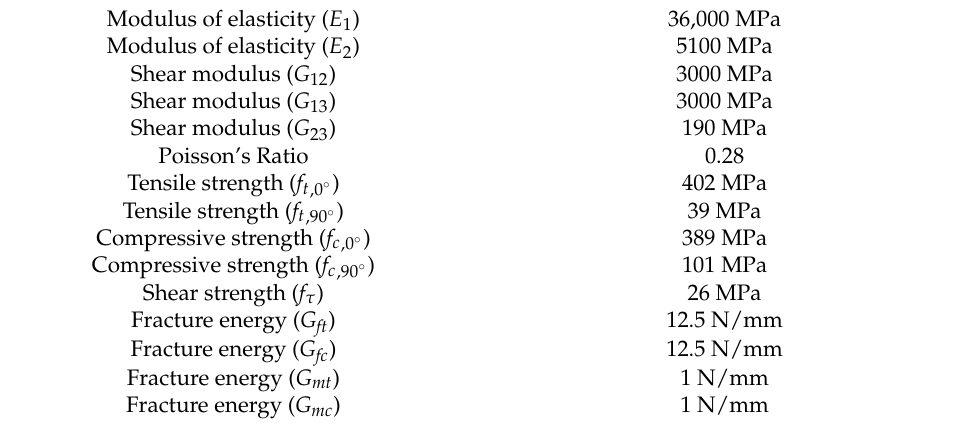
Table 3. Elastic and strength properties and fracture energy of GFRP.